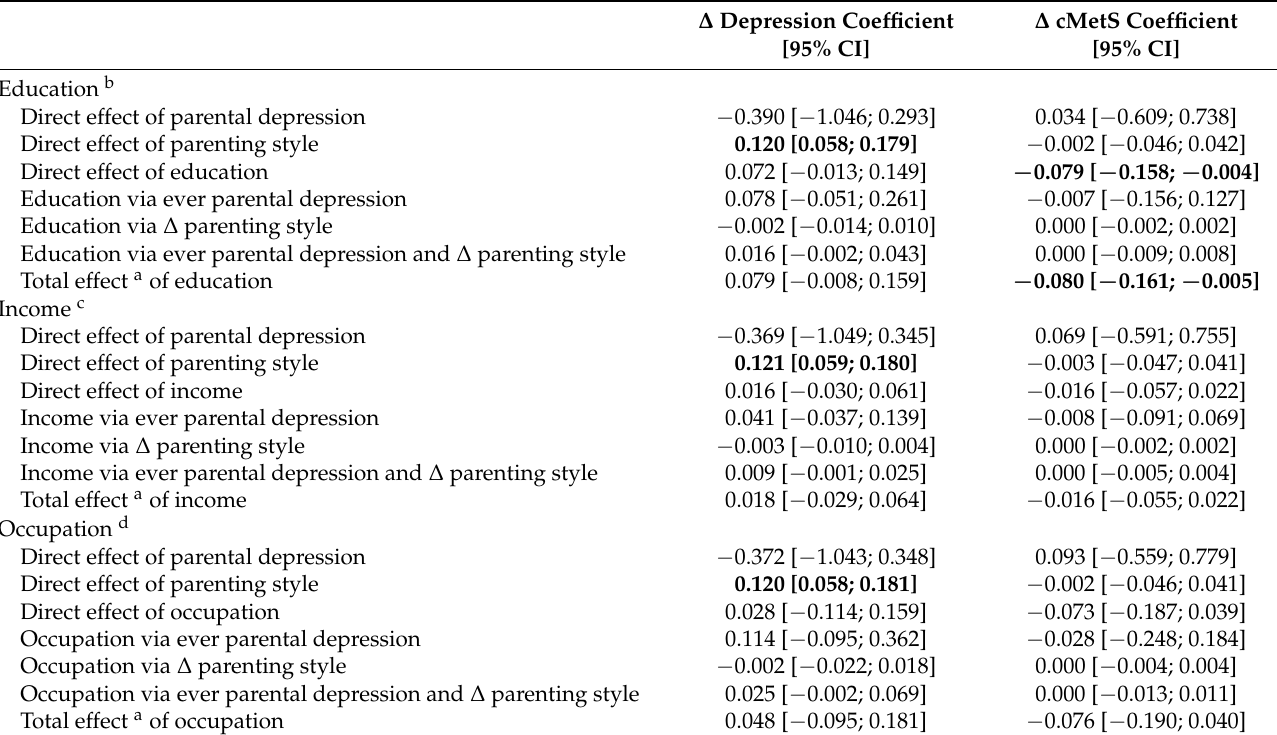
Table 4. The estimated effects of SES, parental depression, and parenting style on changes in depression and cMetS. Statistically significant effects ( p < 0.05) are bolded. Results for all the paths shown in Figure 1b can be seen in Supplementary Figure